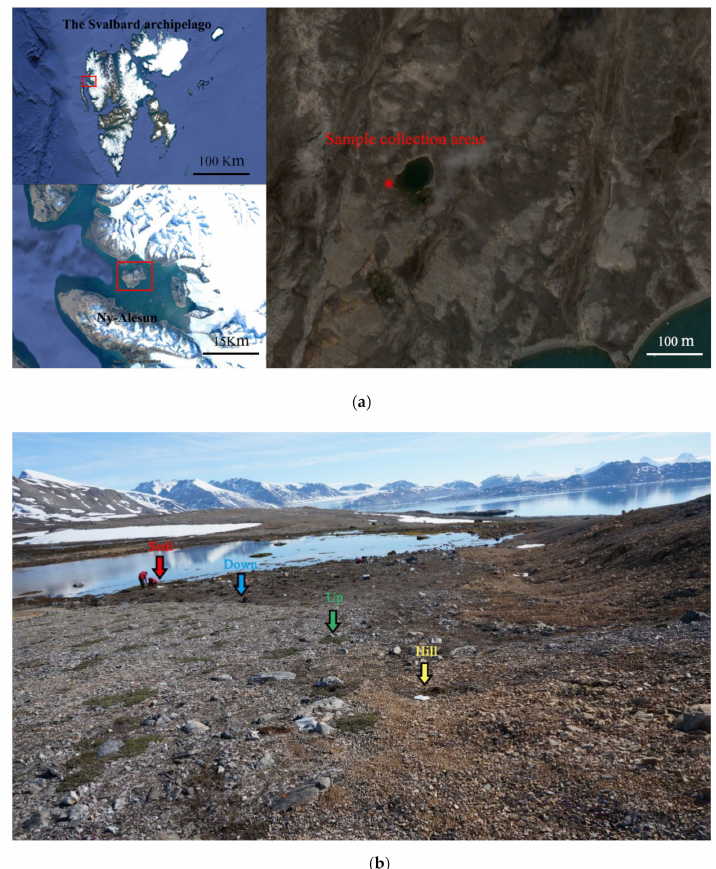
Figure 1. ( a ) Location; ( b ) the sampling sites from an Arctic lake area in the present